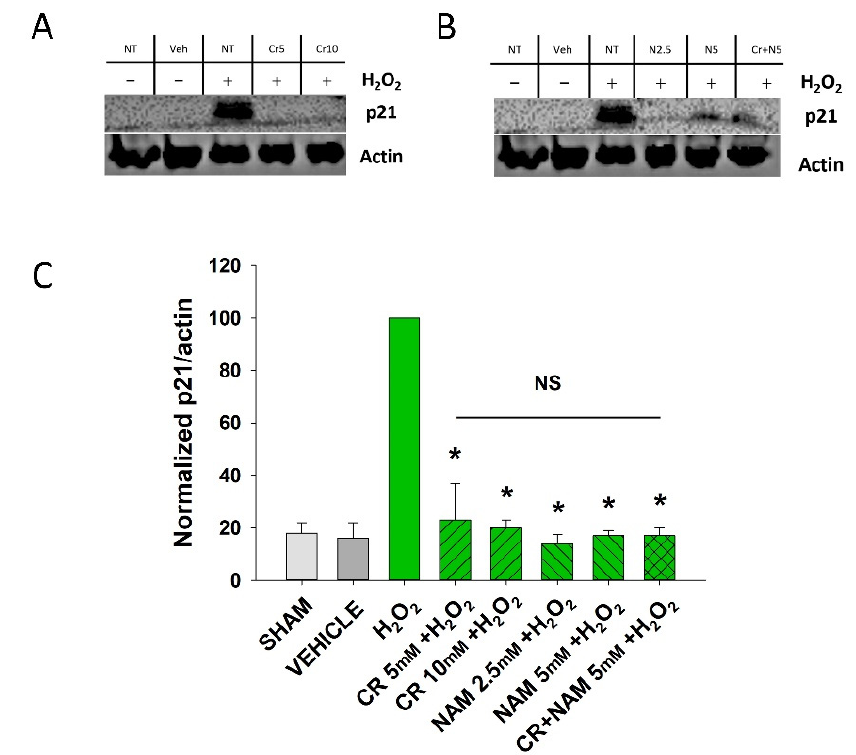
Figure 3. Effect of Cr and NAM on oxidant induced p21 levels. DHF were exposed to various concentrations of 10 mM Cr or 2.5 or 5 mM NAM alone or combined (5 mM each), media alone (SHAM), or water vehicle (1%). Twety-four hours later, the cells were exposed to 600 µ M H 2 O 2 for 2 h, followed by harvesting 72 h later for p21 protein analysis. ( A , B ) representative Western blotting indicating that H 2 O 2 treatment increased p21 protein expression, whereas pretreatment with ( A ) Cr and ( B ) NAM did not result in increased p21 expression levels; ( C ) graphical summary of Western blot images normalized to actin. The data are mean ± SE from 3–4 separate experiments using duplicate samples. Data sets of p21 levels were quantified relative to actin and normalized to an H 2 O 2 group. * Denotes statistically significant changes in the Cr/NAM treated levels in comparison to H 2 O 2 alone. NS, the treatments compared to one another are not statistically significantly different.